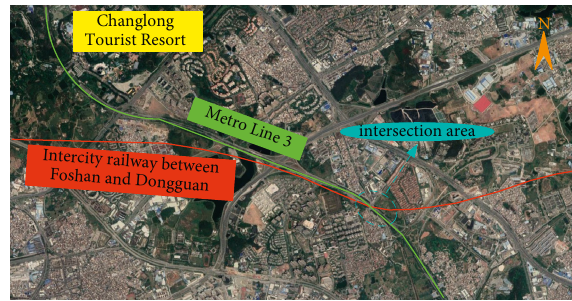
Figure 3: Plan view of project site.